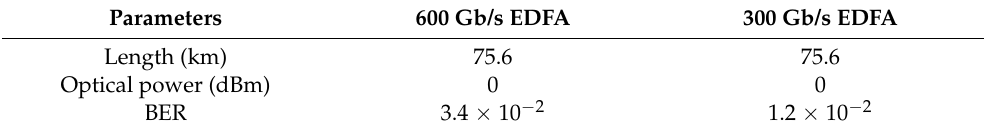
Table 3. Parameters and results of 11-channel WDM, 600 Gb/s [21].